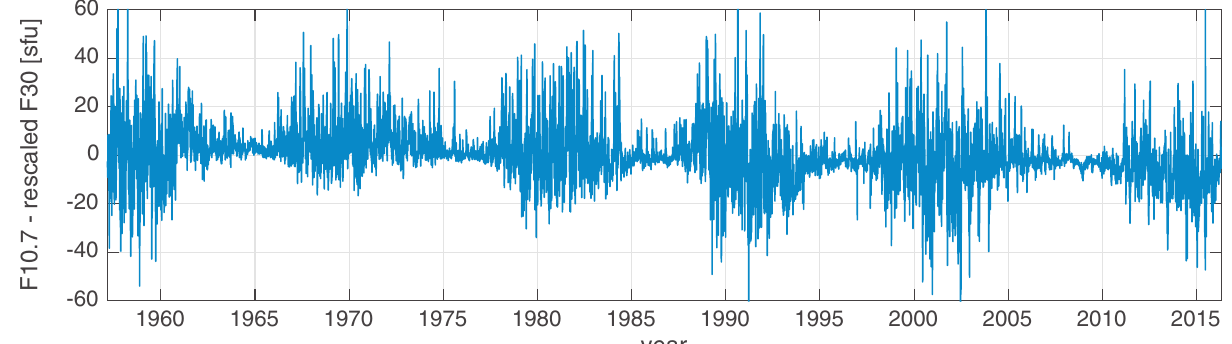
Fig. 2. Difference between F10.7 and F30 after rescaling the latter to F10.7 by using a quadratically nonlinear model. A weak but significant downward trend is apparent, with an average slope of (cid:2) 0.21 [sfu/year].